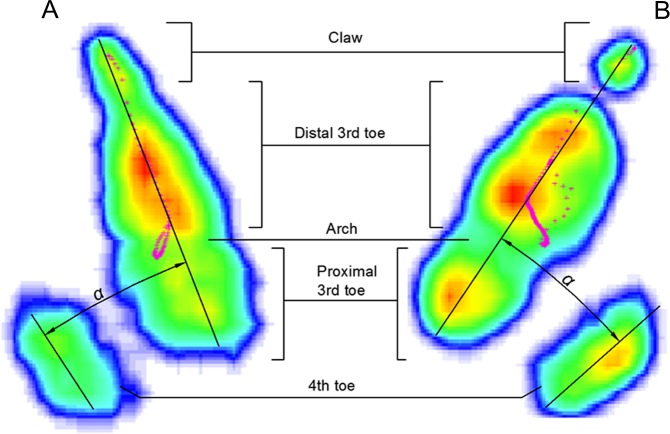
Typical Footscan images of plantar surface of the foot in running on loose sand (A) and solid ground (B).Claw, distal 3rd toe, arch, proximal 3rd toe and 4th toe corresponded to different foot parts. α was the angle between 3rd toe and 4th toe.